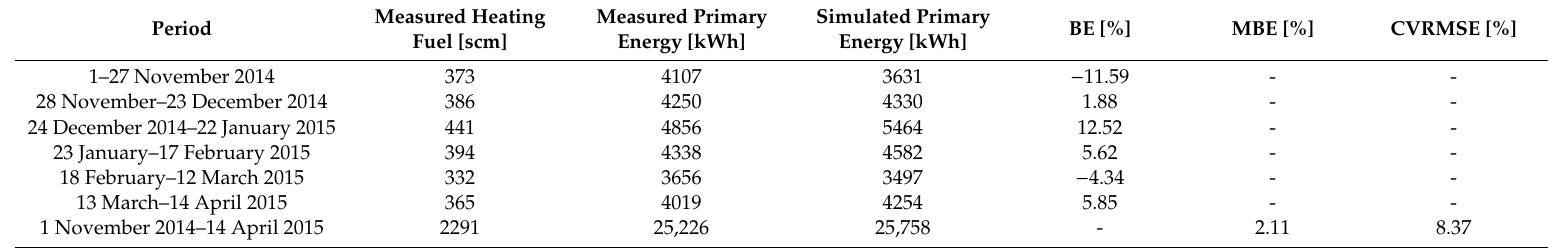
Table 17. Monthly and seasonal heating fuel consumption as measured from bills and as simulated with